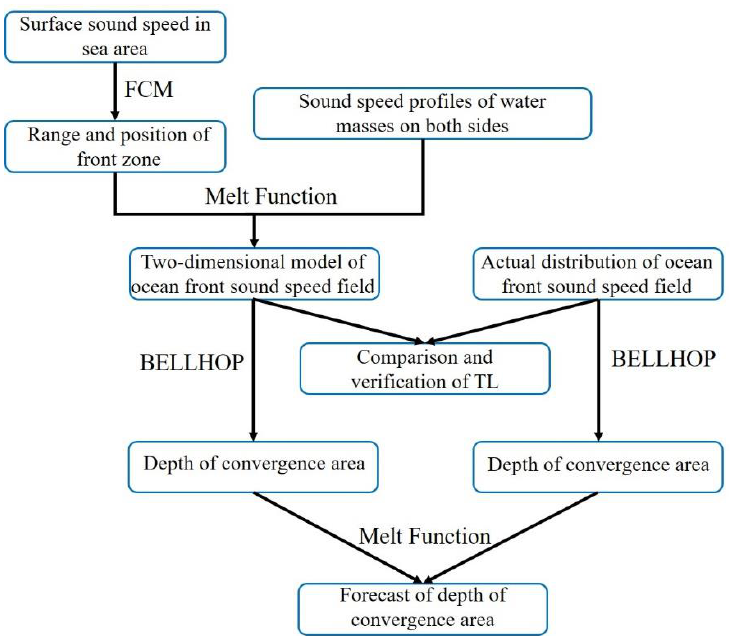
Figure 4. The technical route of the research process. We used FCM to cluster the surface sound speed and detect the frontal zone of KEF; At the same time, sound speed profiles were used to establish the model of the sound speed field through the melt function. Next, the model was compared with the actual ocean front calculated by reanalysis data, which proved its validity. Finally, we proposed the melt function in the model to forecast the depth change of the acoustic convergence area.